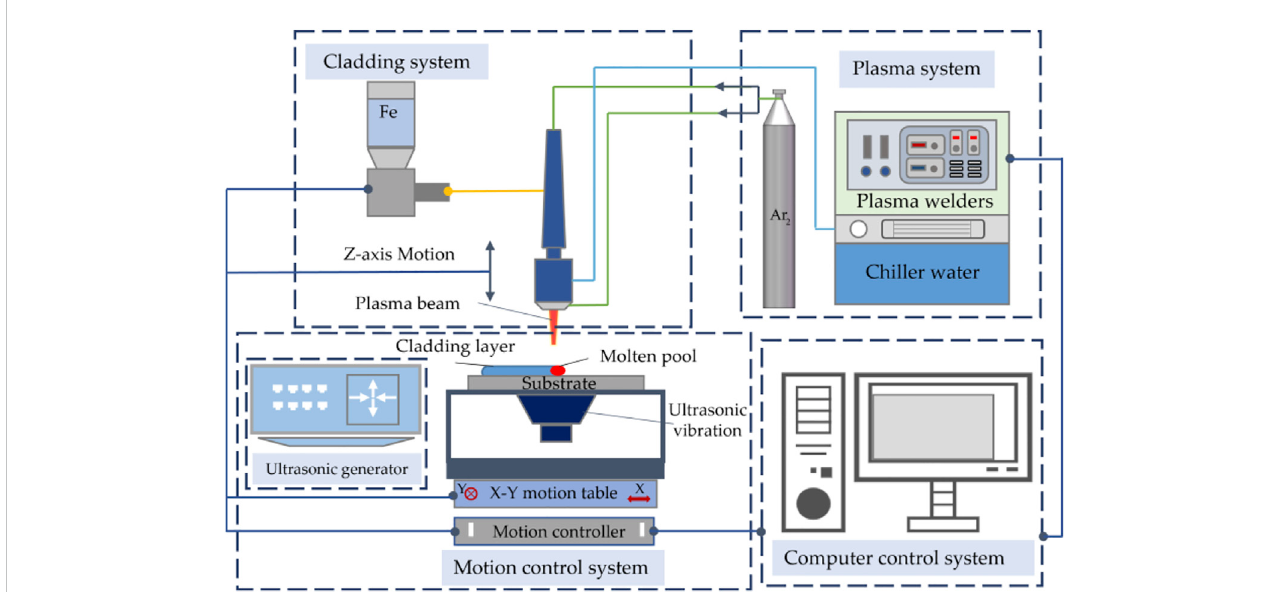
FIGURE 2 Schematic diagram of ultrasonic vibration assistance on the plasma cladding system.